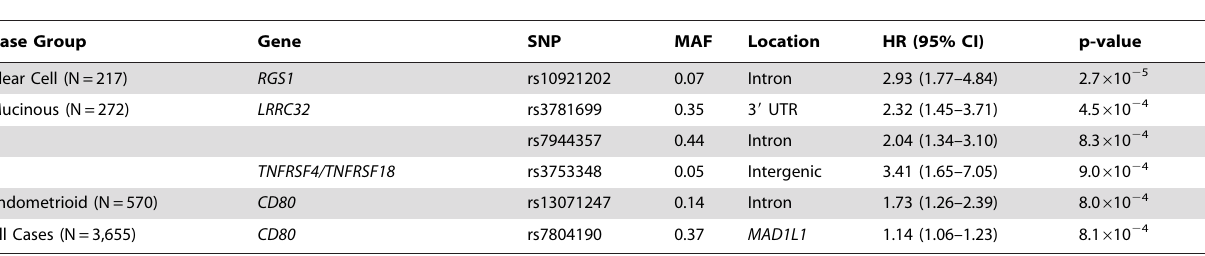
Table 2. Regulatory T Cell SNPs Associated with Overall Survival (p ,